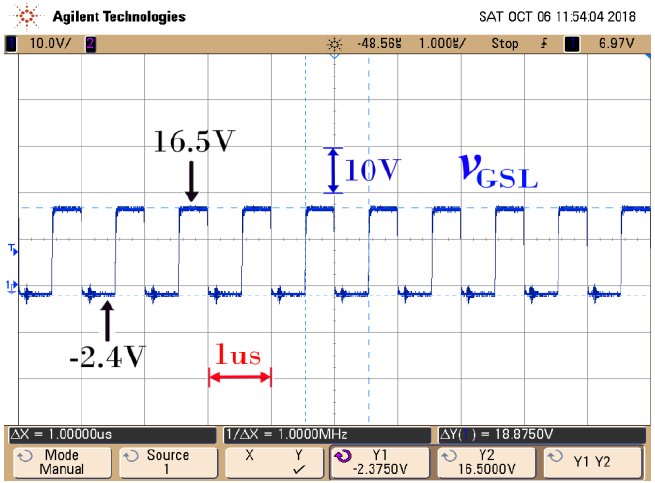
Figure 13. Experimental gate-source voltage waveform of low-side MOSFET.